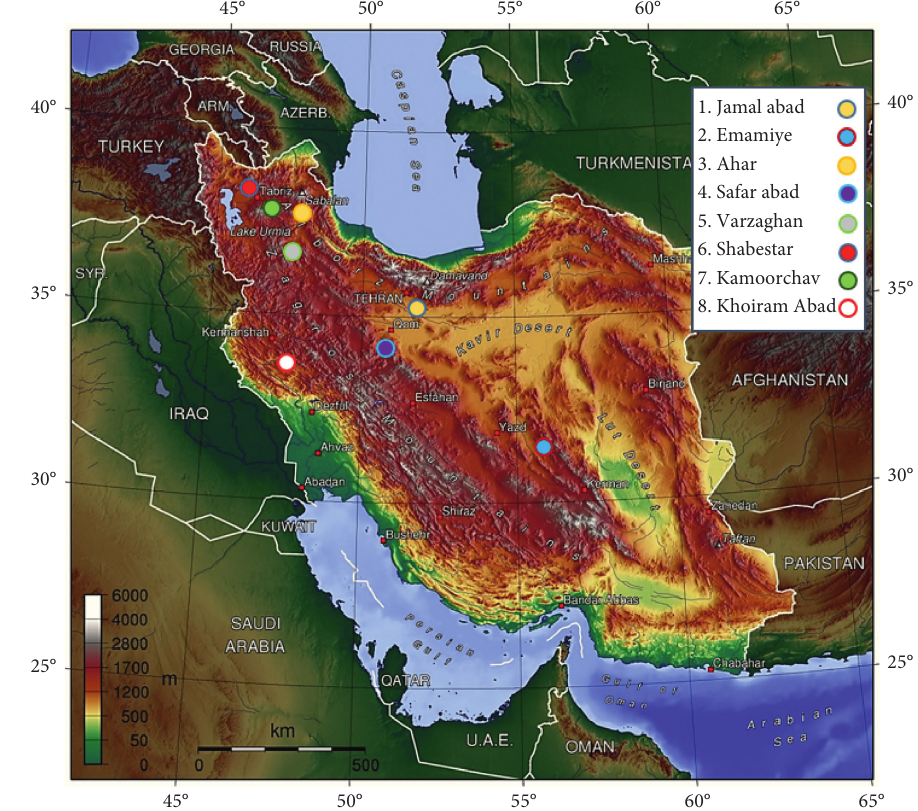
Figure 1: Extraction sites of aggregates studied from Iranian mines.